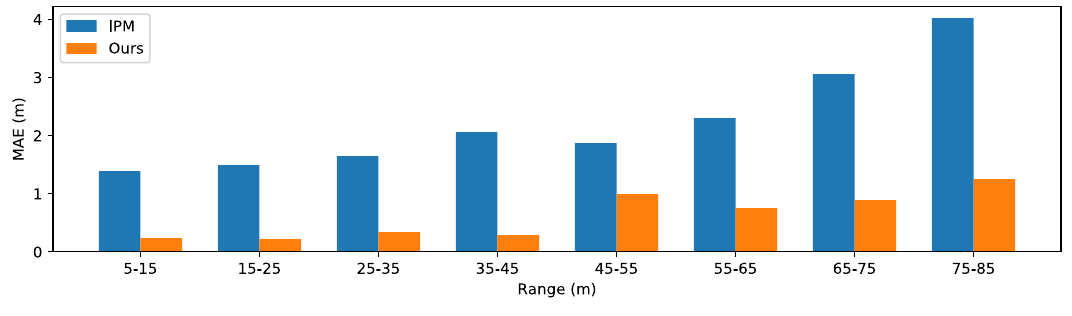
Figure 10. Performance on cars in the test set of the processed synthetic Apollo dataset.